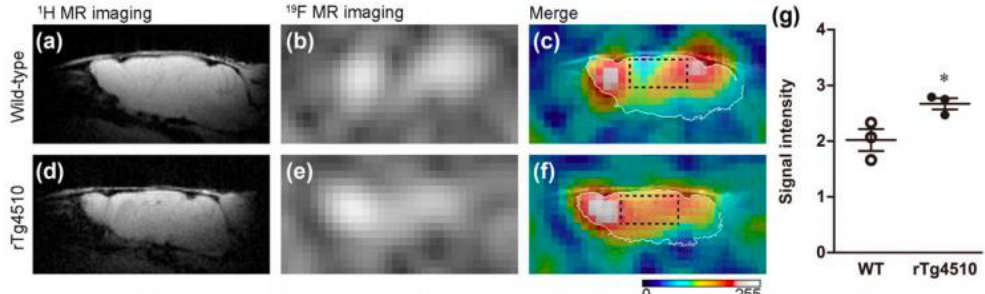
Figure 3. In vivo tau detection in wild-type ( a – c ) and rTg4510 ( d – f ) mice using 19F MRI after the injection of Shiga-X35 [32]. The proton MRI images ( a , d ) were used for brain localization. ( b , e ) 19F MRI images acquired after Shiga-X35 injection. Fluorine images were superimposed on top of high-resolution proton images ( c , f ). The Shiga-X35 uptake was significantly (* p = 0.044) higher in rTg4510 mice compared to the healthy controls ( g ). Images and graph are reprinted with permission from the publisher [32].